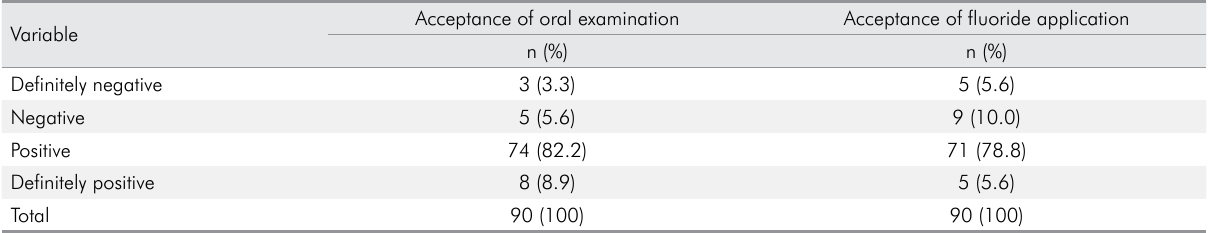
Table 3. Frankl Behavior Rating Scale scores for children according to their acceptance of oral examination and fluoride application. Variable